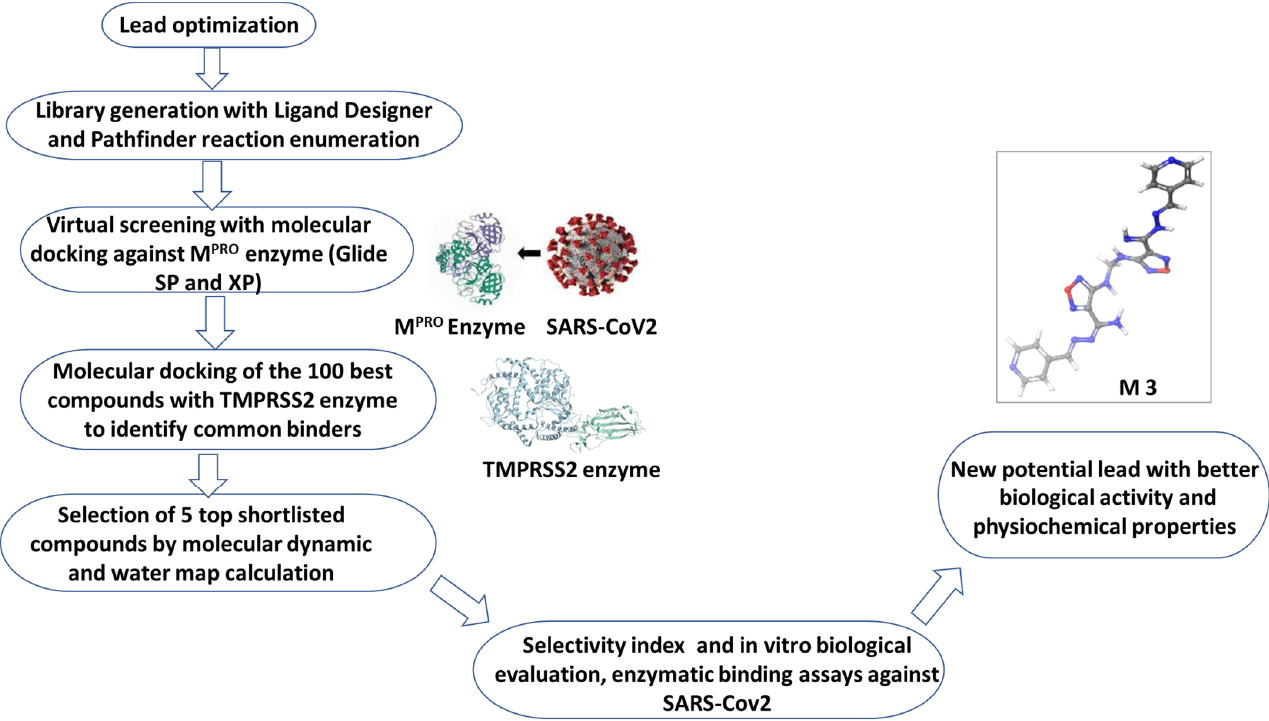
Figure 1. Flowchart of rational lead design and drug discovery of M3 .